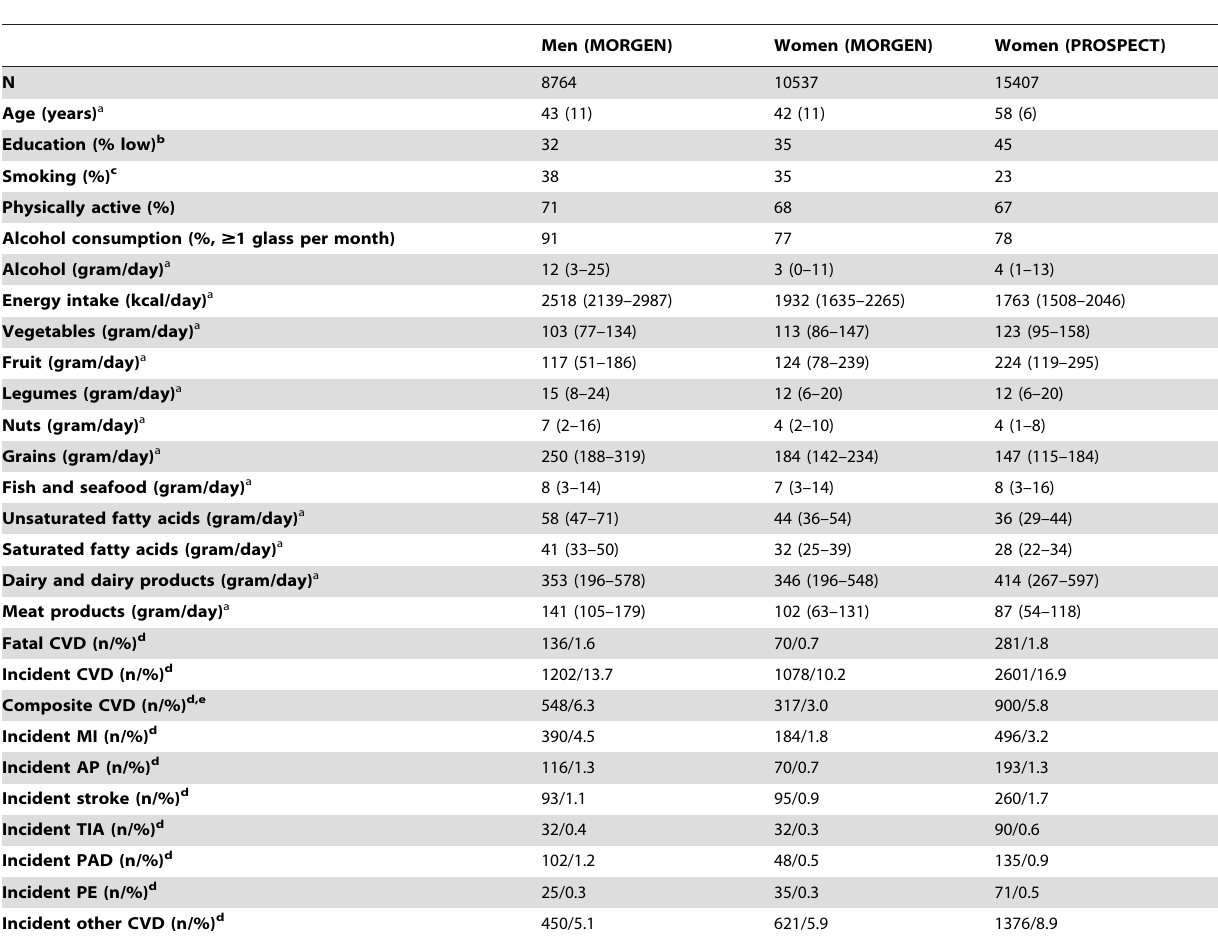
Table 1. Participants’ characteristics at baseline and CVD incidence, by sex and cohort, the EPIC-NL